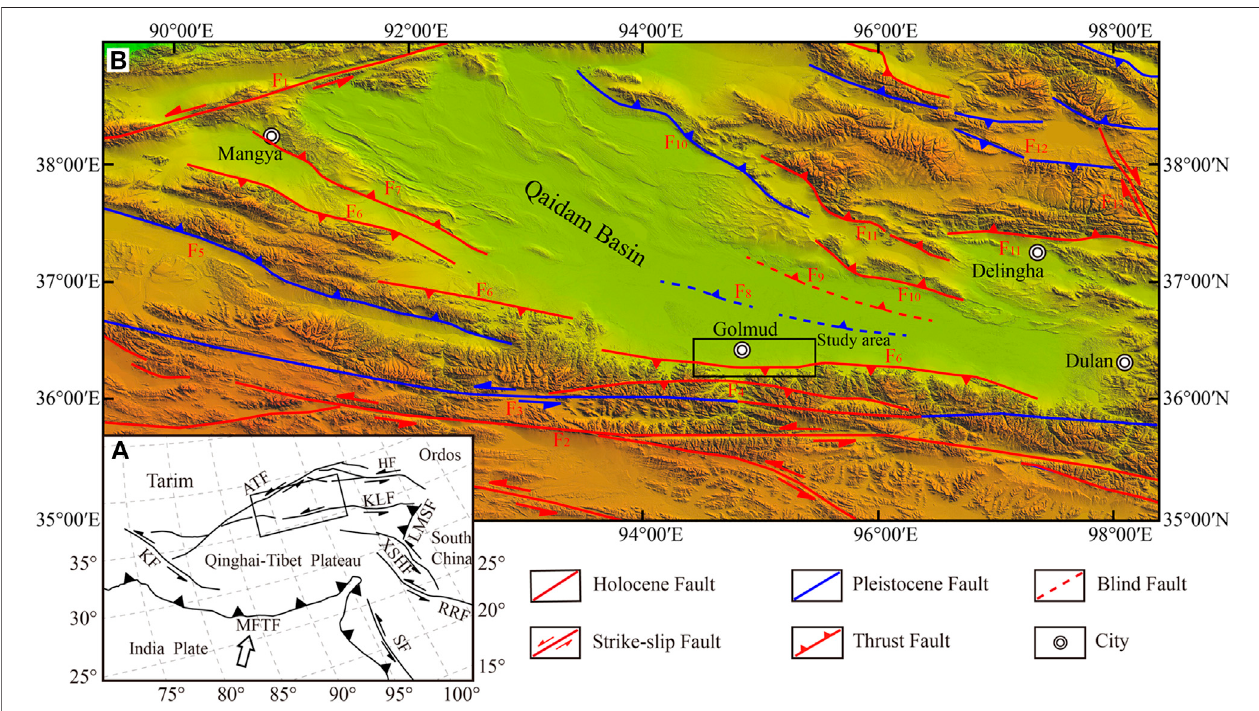
FIGURE 1 | Active tectonics of the Qaidam Basin and surrounding area. (A) Inset map shows the regional plate tectonic setting. Abbreviations of faults are as follows: AFT, Altyn Tagh fault; HF, Haiyuan fault; KLF, Kunlun fault; KF, Karakoram fault; LMSF, Longmenshan fault; XSHF, Xianshuihe fault; RRF, Red River fault; SF, Sagaing fault; MFTF, Main Frontal thrust. Modi fi ed from Tapponnier et al. (2001). (B) More detailed map of faults in the Qaidam Basin. Modi fi ed from China earthquake administration, 2015. The black rectangle represents the approximate area of Figure 2 . F 1 -Altyn Tagh fault, F 2 -Kunlun fault, F 3 -Kunzhong fault, F 4 -Nanshankou fault, F 5 -Wulukesu fault, F 6 -Southern marginal fault of the Qaidam Basin, F 7 -Mangya-Huatugou fault, F 8 -South-central fault of Qaidam Basin, F 9 -North-central fault of Qaidam Basin,